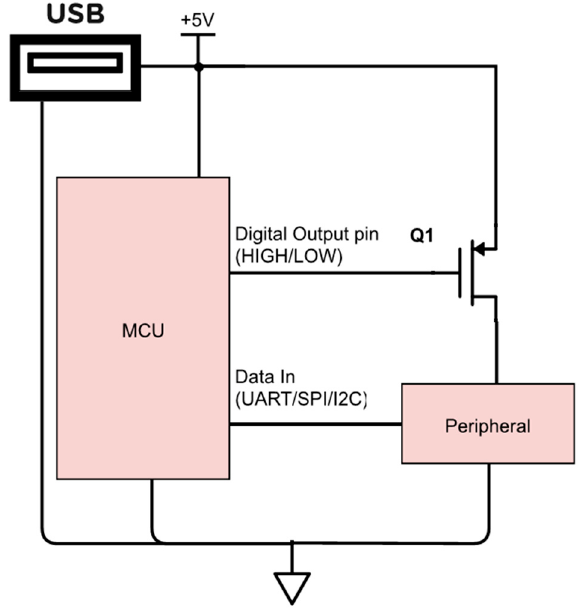
Figure 1. Power gated peripherals controlled by MCU [16].